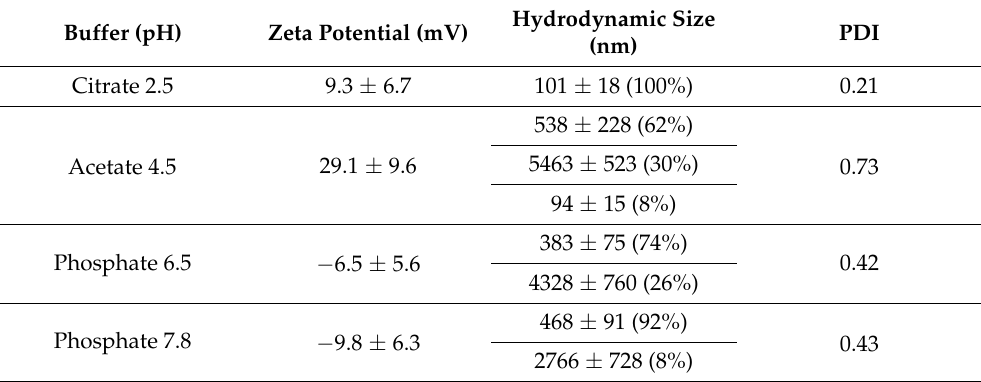
Table 3. Bioparticle structural characteristics in different buffer solutions, all at 40